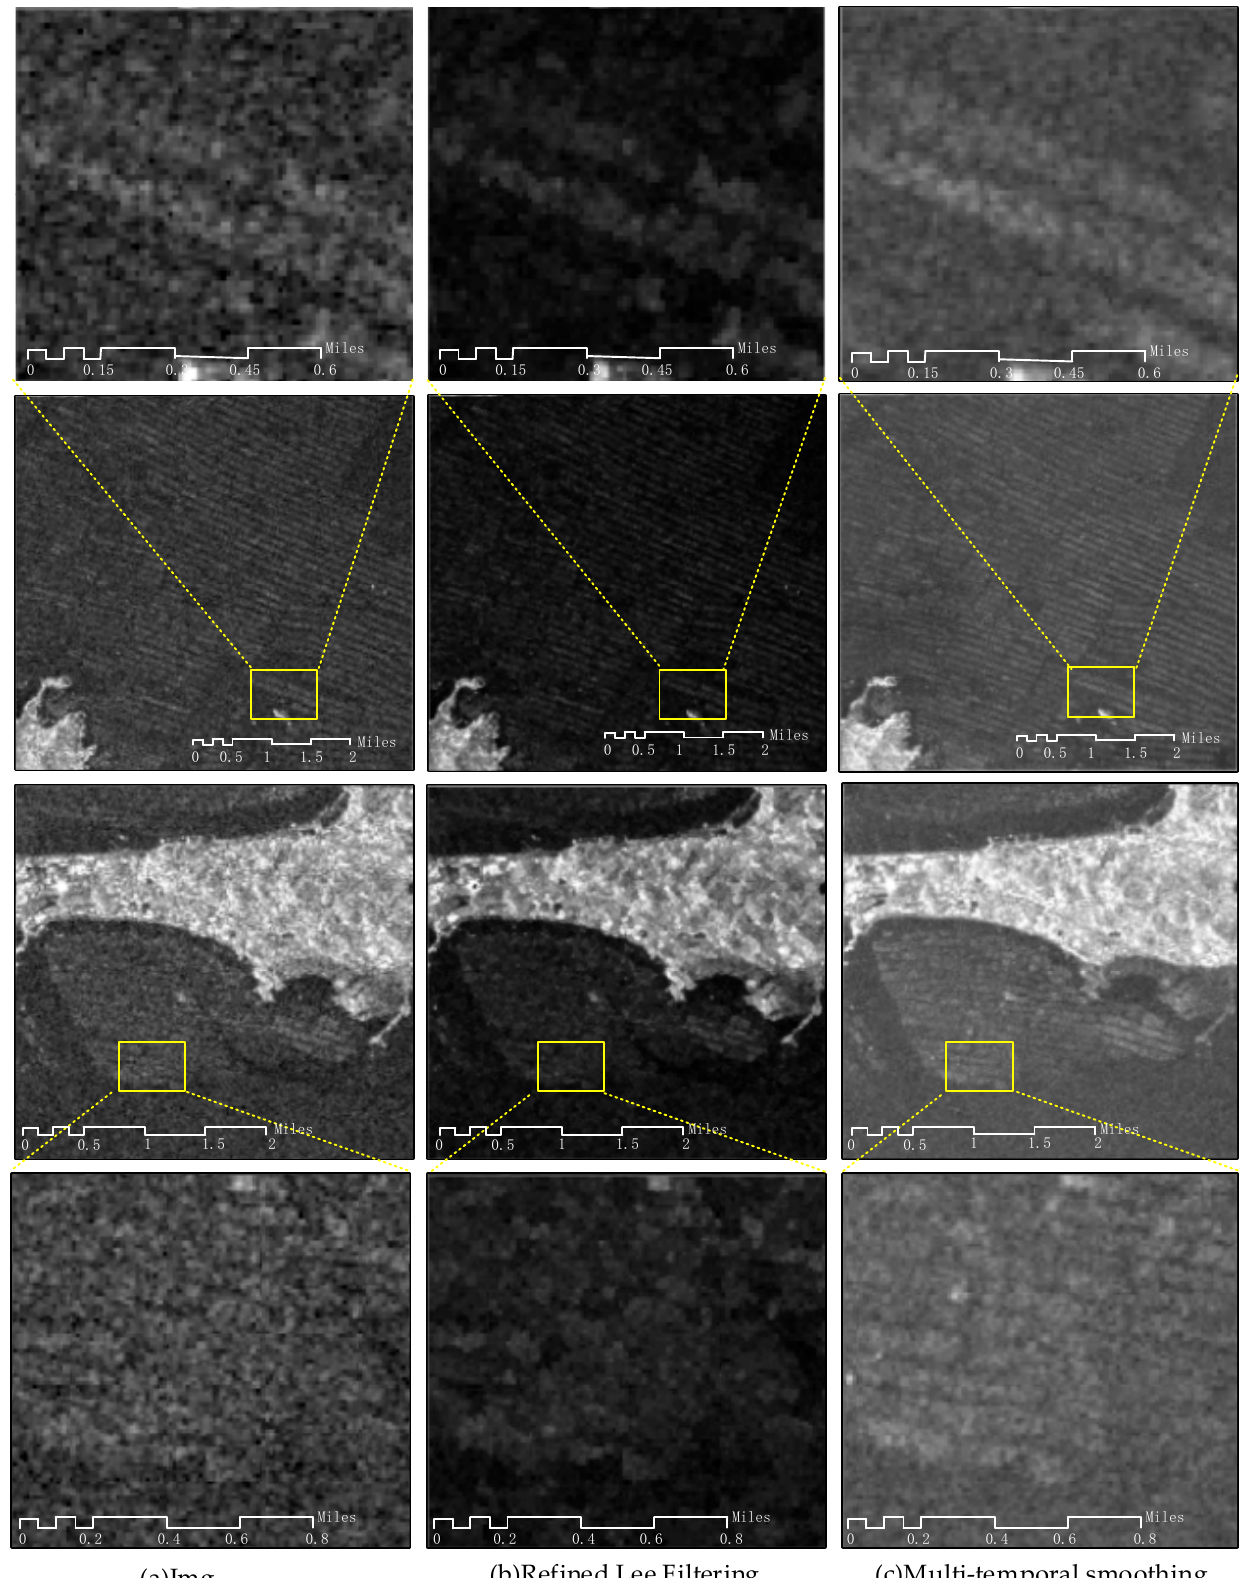
Figure 8. Overview of the results for data pre-processing. ( a ) shows the original image; ( b ) shows the result of refined Lee filtering obtained using SNAP (the ESA Sentinel Applications Platform); ( c ) shows the result of multitemporal synthesis.